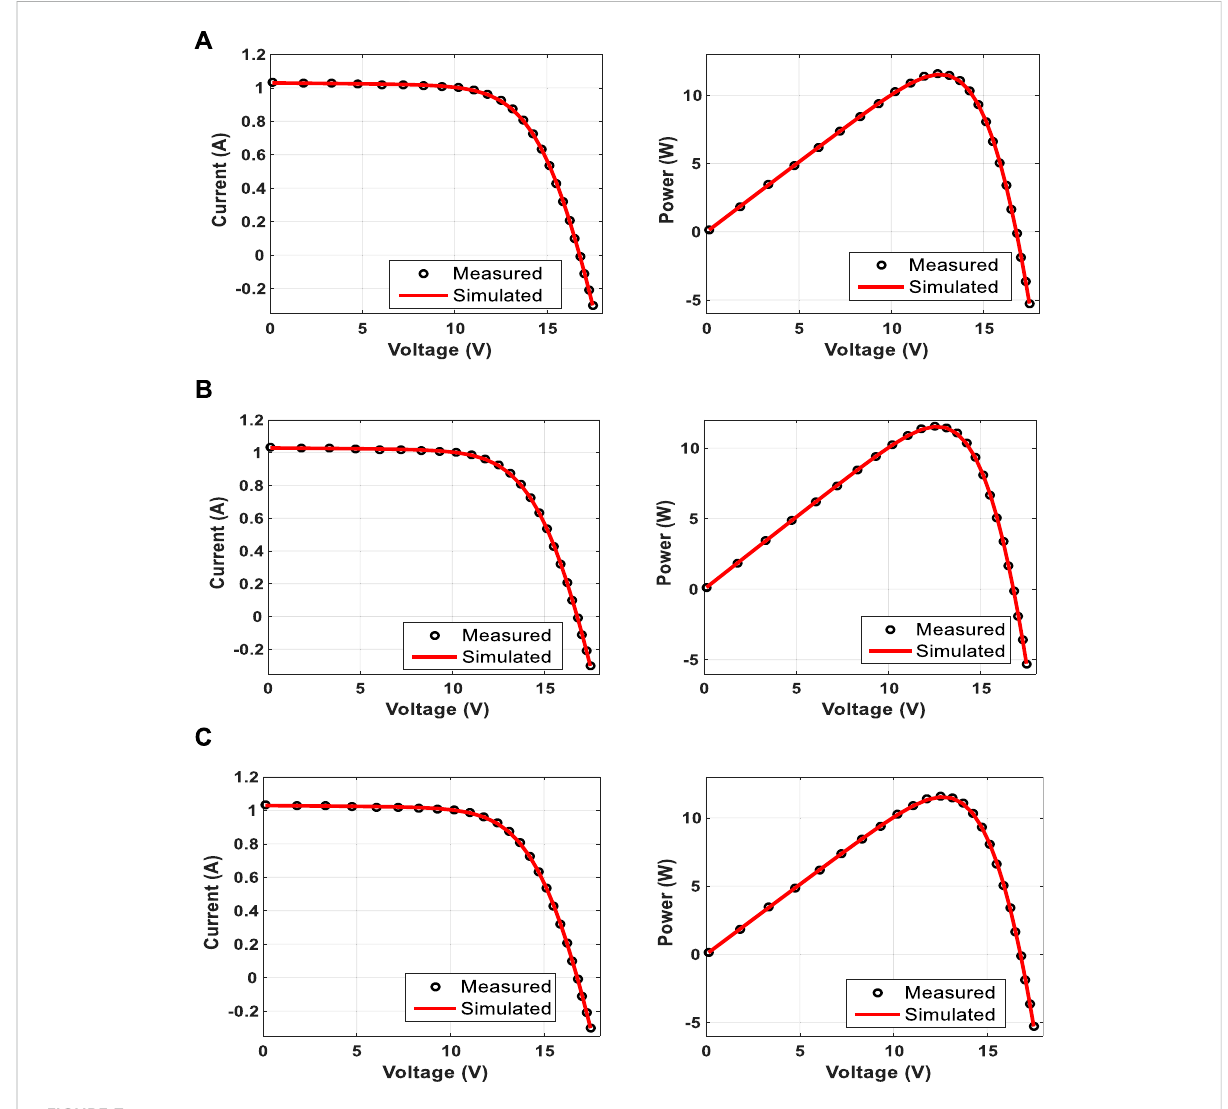
FIGURE 7 Measured and simulated I – V and P – V curves of the PWP-201 PV panel. (A) SDM, (B) DDM, and (C)